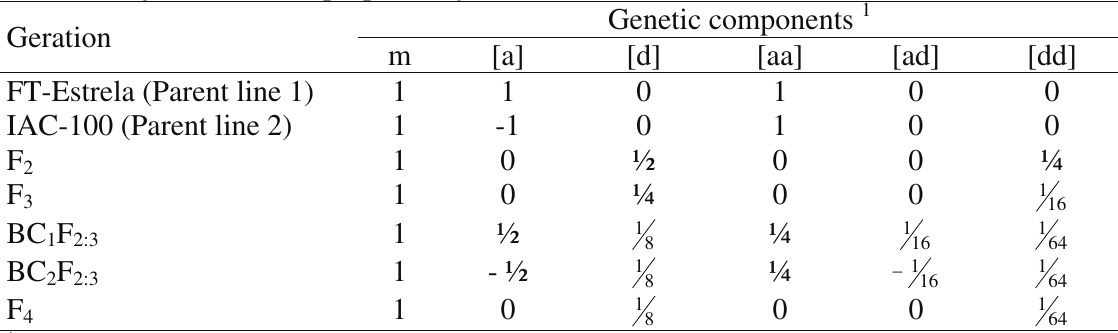
Table S1 – Genetic components of the expected means for parent lines and their segregating generations, involving additive, dominance and di-genic epistatic interactions used in the joint scale test proposed by Cavalli